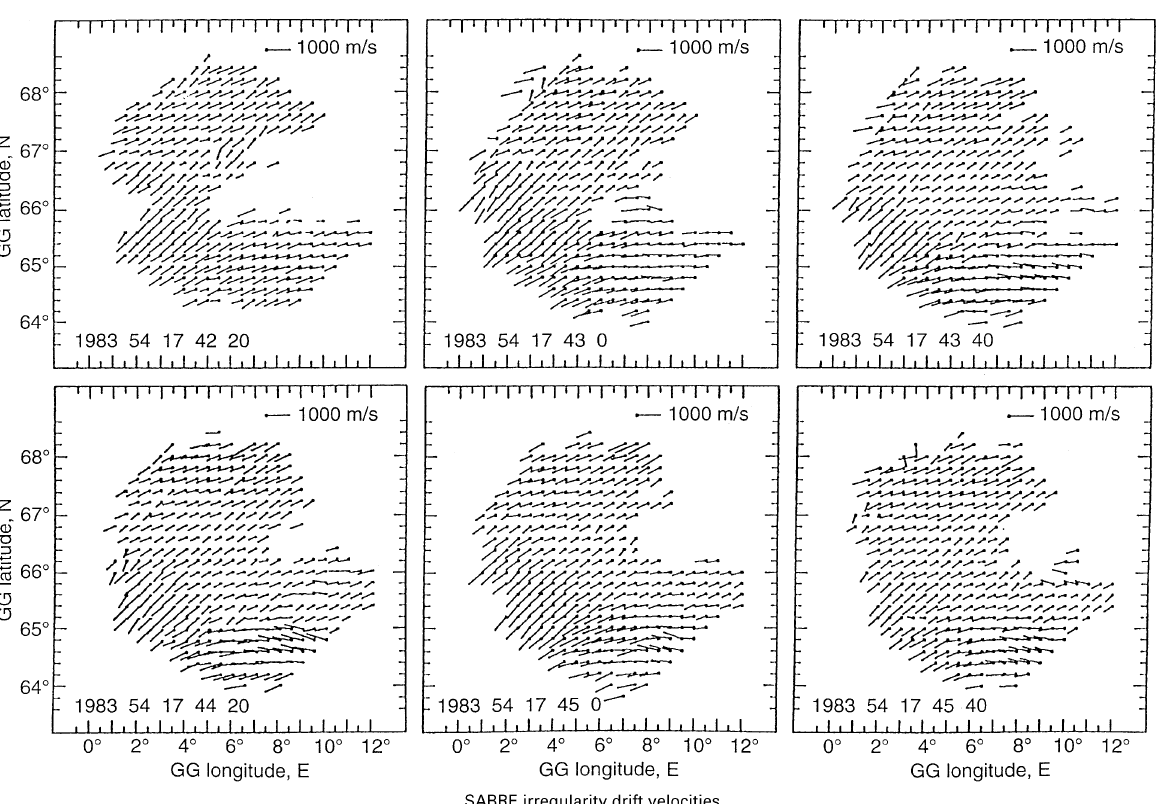
about 17:43 UT toward the equatorward edge of the field of view and remains until after the end of the second pulsation